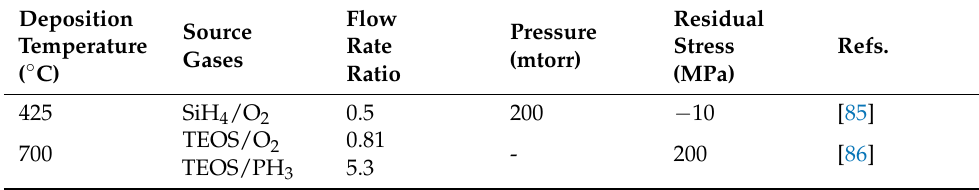
Table 3. Resultant residual stresses in as-deposited SiO 2 thin-films deposited using LPCVD.